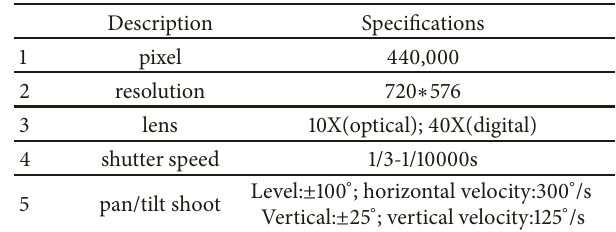
Table 1: Main product parameters of the monocular PTZ